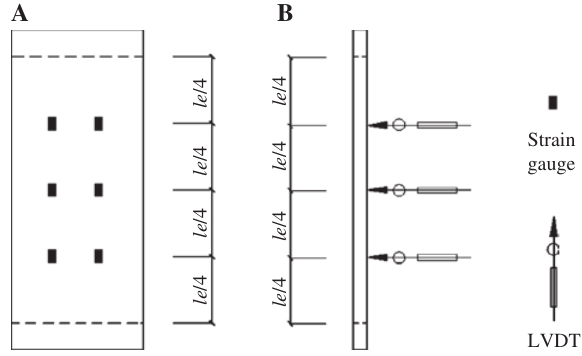
Figure 6: Instrumentation of Specimen WP5: (A) strain gauge and (B) LVDT